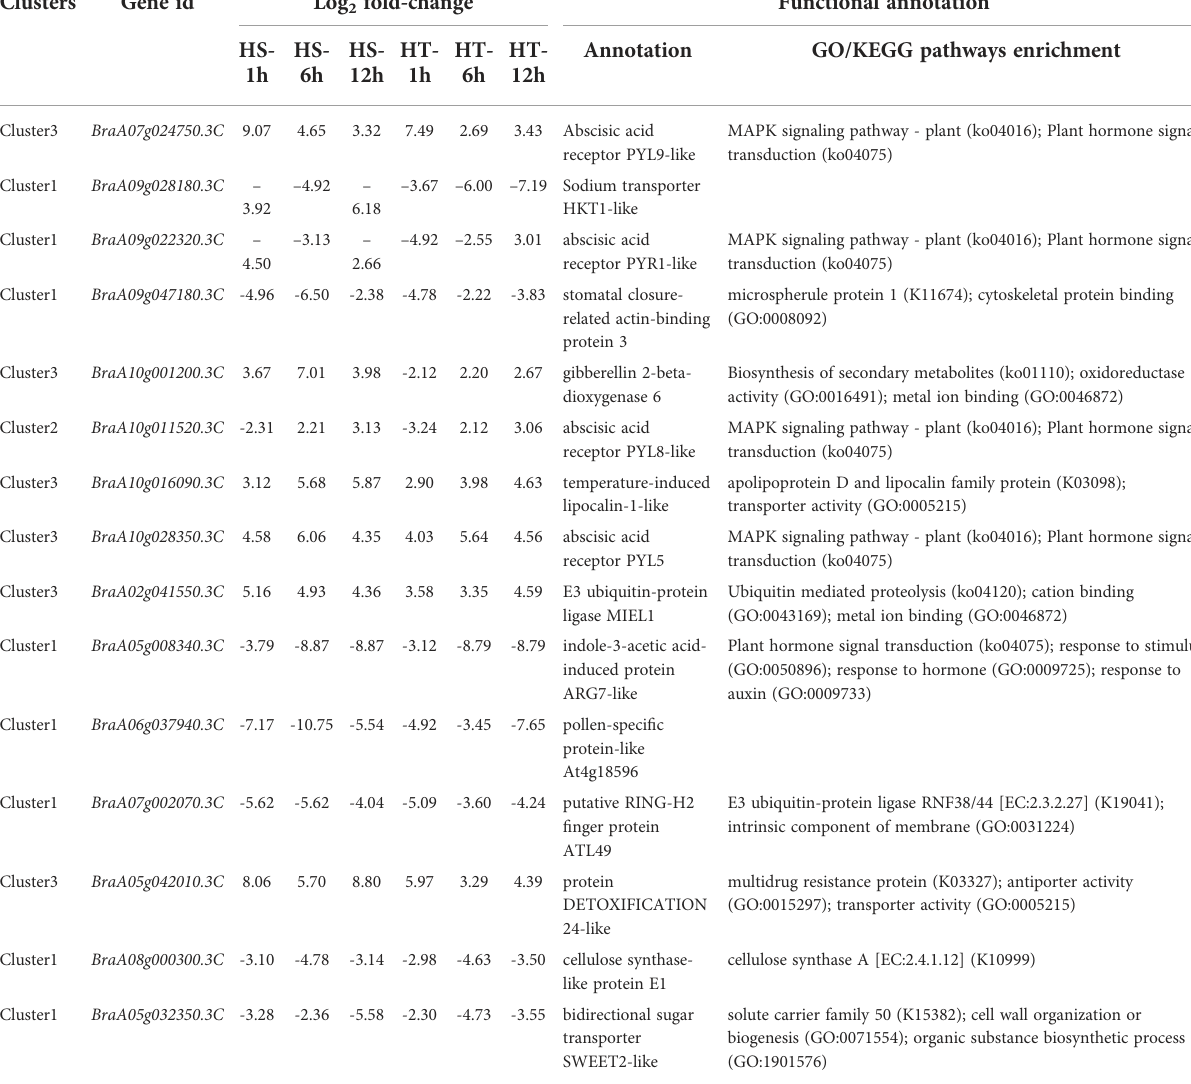
TABLE 1 List of top potential differentially expressed genes involved in heat tolerance in fl owering Chinese cabbage. Clusters Gene id Log 2